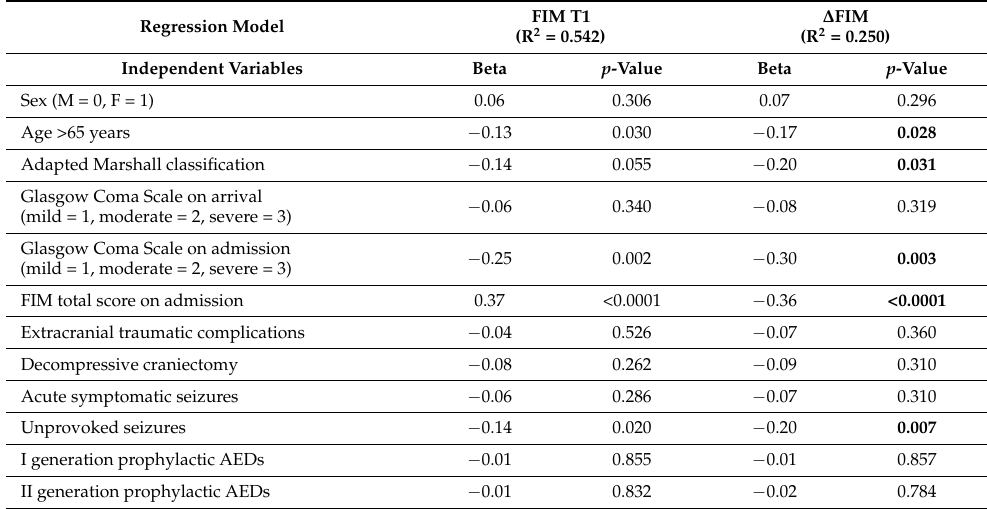
Table 2. Multiple linear regression models to evaluate the potential predictors of functional outcome, in terms of FIM on discharge (FIM T1) and FIM variation during rehabilitation ( ∆ FIM).